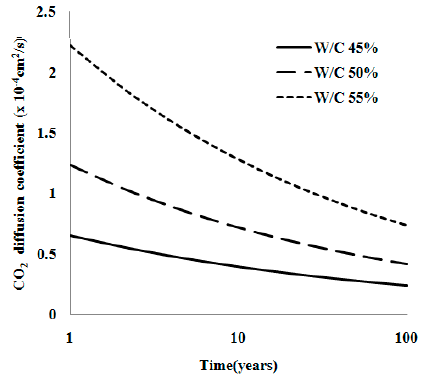
Figure 1. CO 2 di ff usion coe ffi cient according to time. Figure 1. CO 2 diffusion coefficient according to time. Figure 1. CO 2 diffusion coefficient according to time.